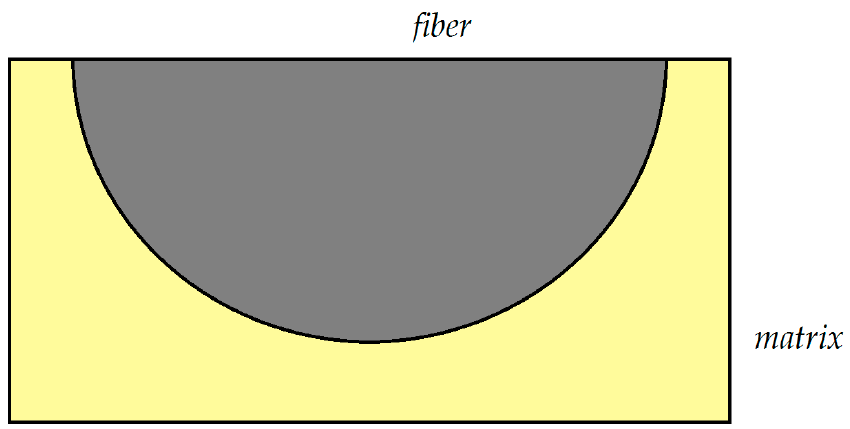
Figure 1. The representative unit cell for finite element analysis (Model 1).